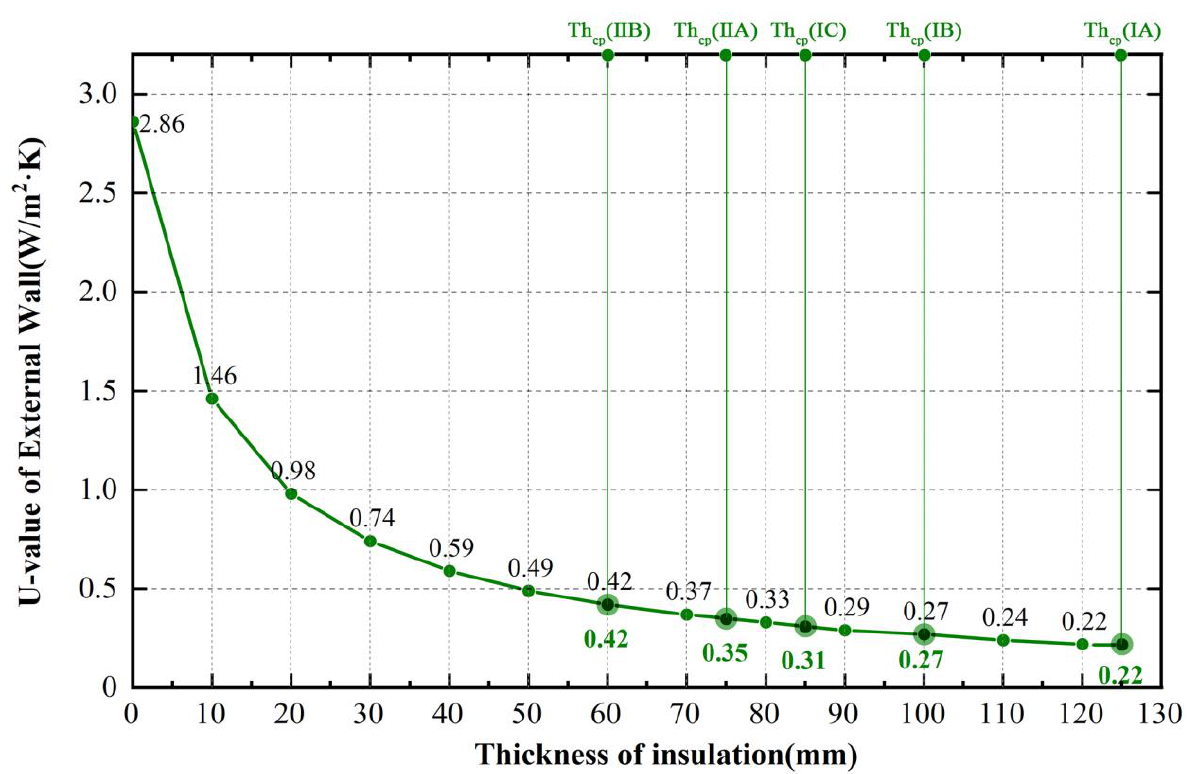
Figure 4. Th insulation and corresponding U-value of external wall (the values denoted by dark-green circles were applied in the simulation, while those denoted by light-green circles represent values in the current practice standards). Table 4. Range of Th insulation in each city in the simulation settings.